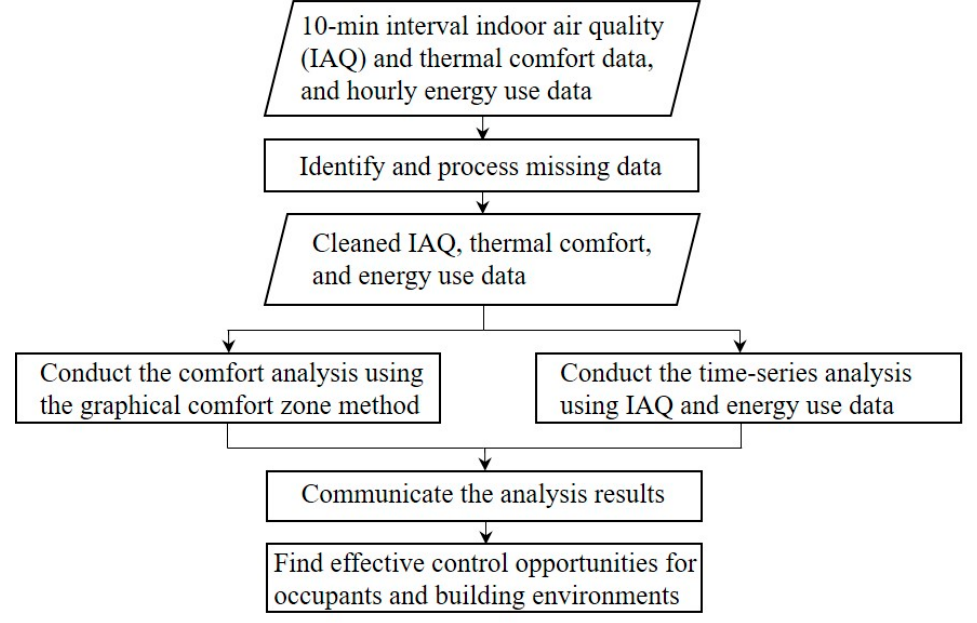
Figure 4. Overall process to analyze real-time energy use, thermal comfort, and indoor air quality.